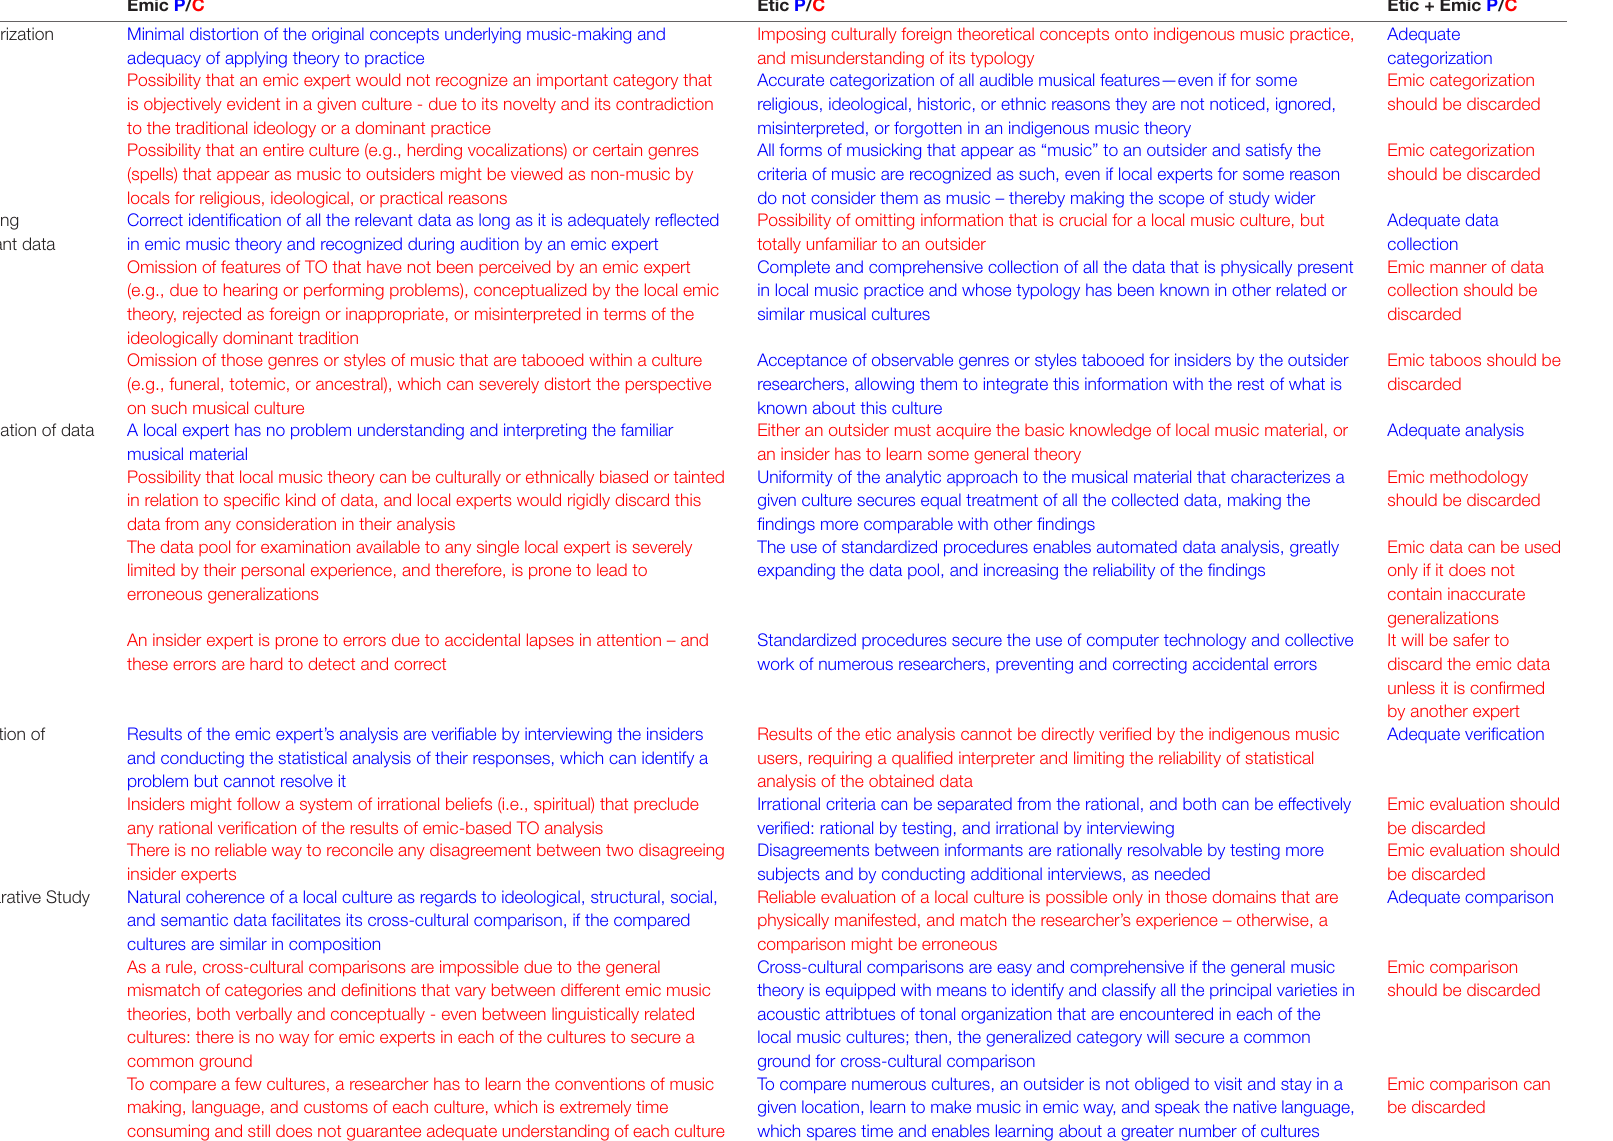
TABLE 2 | Pros and cons (P/C) of purely etic, emic, and combined “etic + emic” approaches to analyzing music structures.